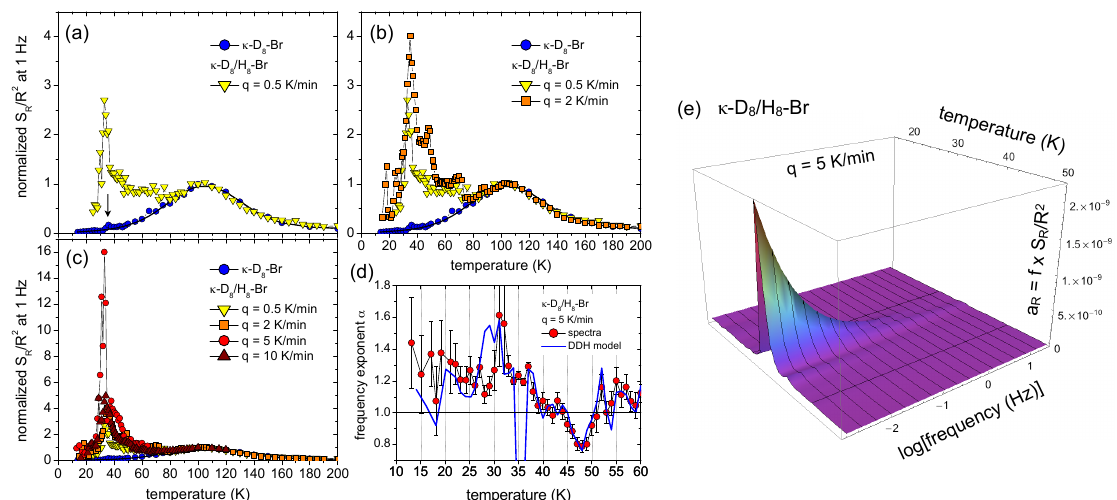
Figure 11. Critical slowing down of charge fluctuations. ( a ) resistance noise PSD S R / R 2 ( T , f = 1Hz ) of slowly-cooled κ -H 8 /D 8 -Br (yellow triangles) in comparison to the data of κ -D 8 -Br (blue circles) normalized to the value of the local maximum around 100K. The black arrow indicates a peak in the noise level, cf. data of the same sample shown in Figure7a. ( b , c ) measurements for increasing cooling rates q . Note the rescaling of the ordinate in ( c ); ( d ) frequency exponent α ( T ) for q = 5K/min, where the noise level shown in ( c ) is largest. The line represents the DDH model calculation; ( e ) relative noise level a R f S R / R 2 vs. f vs. T for the same cooling rate. Reprinted with permission from [53]. ≡ × Copyright (2015) by the American Physical